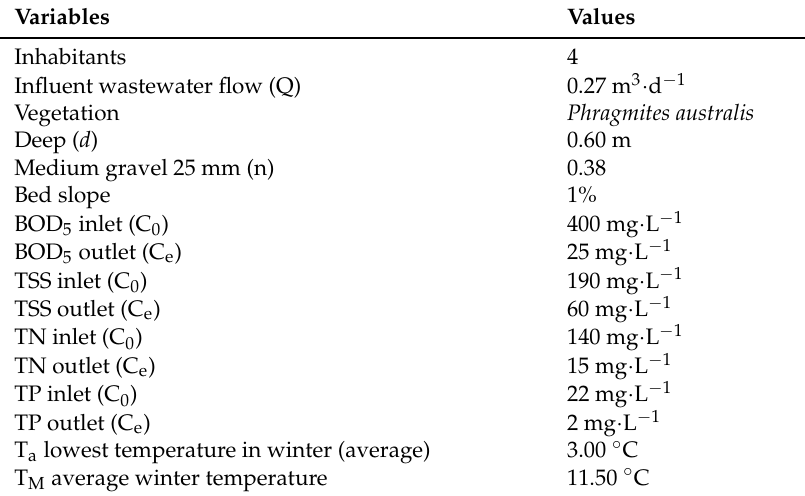
Table 6. Variables considered for redesign the HF-CW